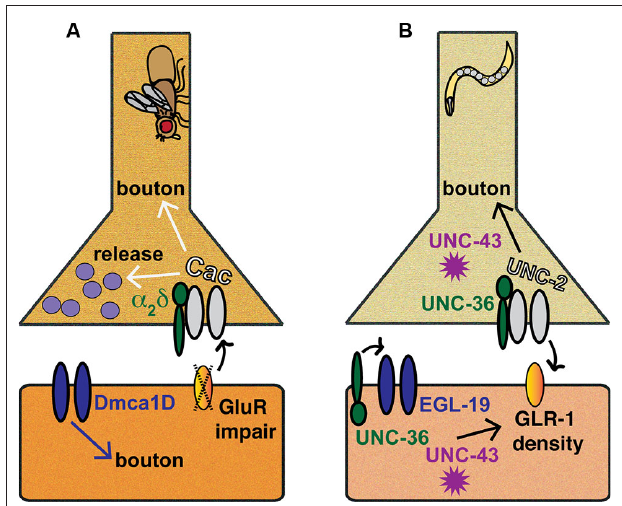
FIGURE 2 | Invertebrate models of Ca V -directed homeostatic plasticity. Inspection of the Drosophila melanogaster NMJ has provided a wealth of information regarding the roles VGCCs and associated molecules play in homeostatic plasticity, as has examination of C. elegans preparations, such as the ventral nerve cord (VNC) or the NMJ. (A) Drosophila NMJ. Pharmacological or genetic impairment of postsynaptic glutamate receptors triggers a retrograde signaling process that results in enhanced presynaptic Cac/Ca V 2 function and increased neurotransmitter release. Additionally, Cac/Ca V 2, α 2 δ , and Dmca1D/Ca V 1 all affect synaptic bouton development or maturation at the NMJ. (B) C. elegans synapses. At the C. elegans VNC, the coordinated functions of UNC-2/Ca V 2, EGL-19/Ca V 1, UNC-36/ α 2 δ